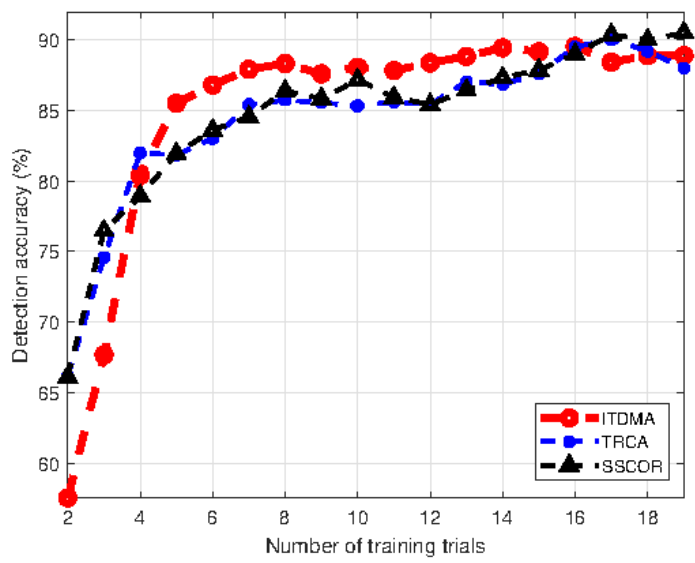
Figure 8. Detection accuracy comparison versus the number of training